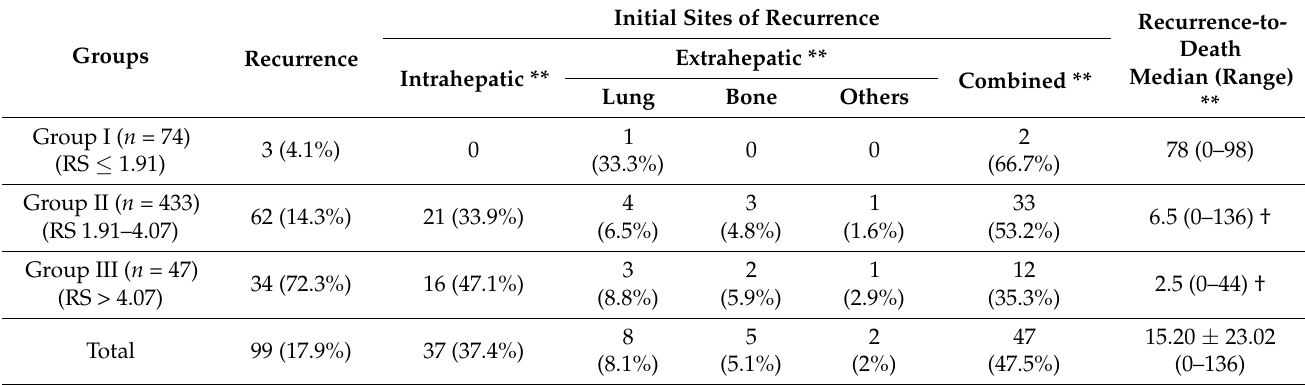
Table 7. Recurrence rate and recurrence pattern in three groups based on risk score RS* and comparison between groups.